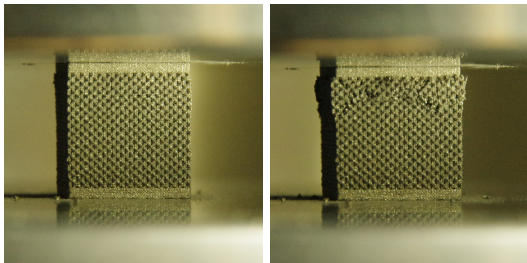
Figure 3. A specimen from the B series before loading (left) and during loading